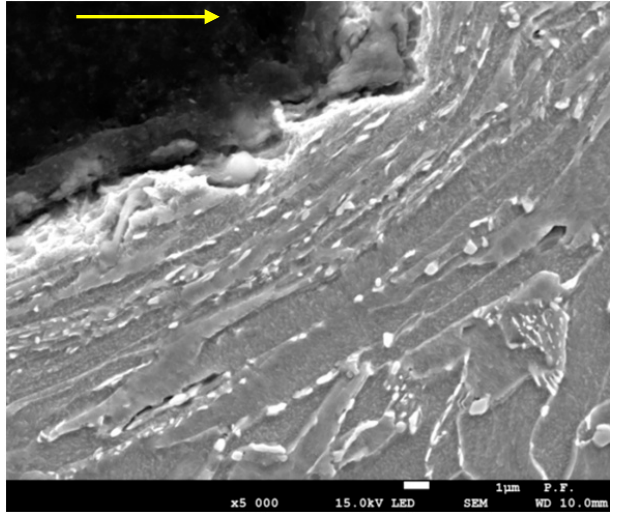
Figure 12. Metallographic microstructure of cross-sectional area of cut (a pressure of 340 MPa and a cutting speed of 300 mm/min).